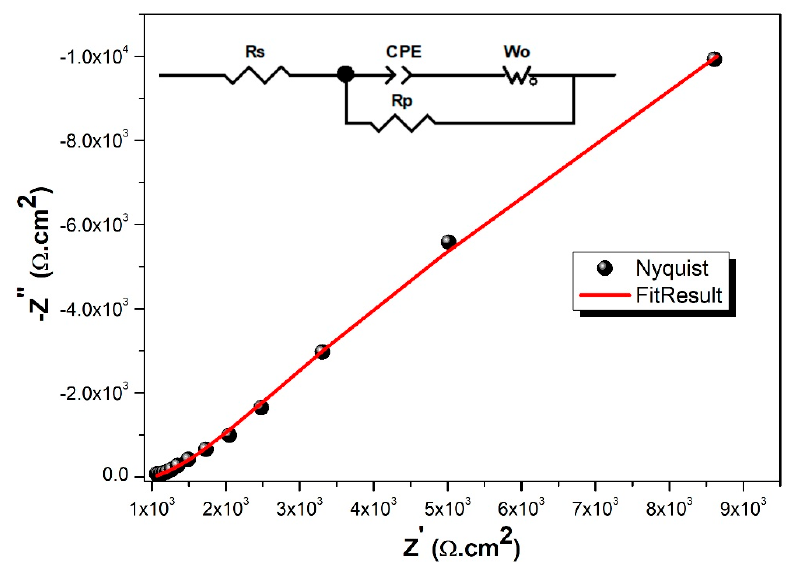
Figure 8. The EIS (Nyquist) diagram of ZnBi 2 O 4 in NaOH solution, inset: equivalent electrical circuit.